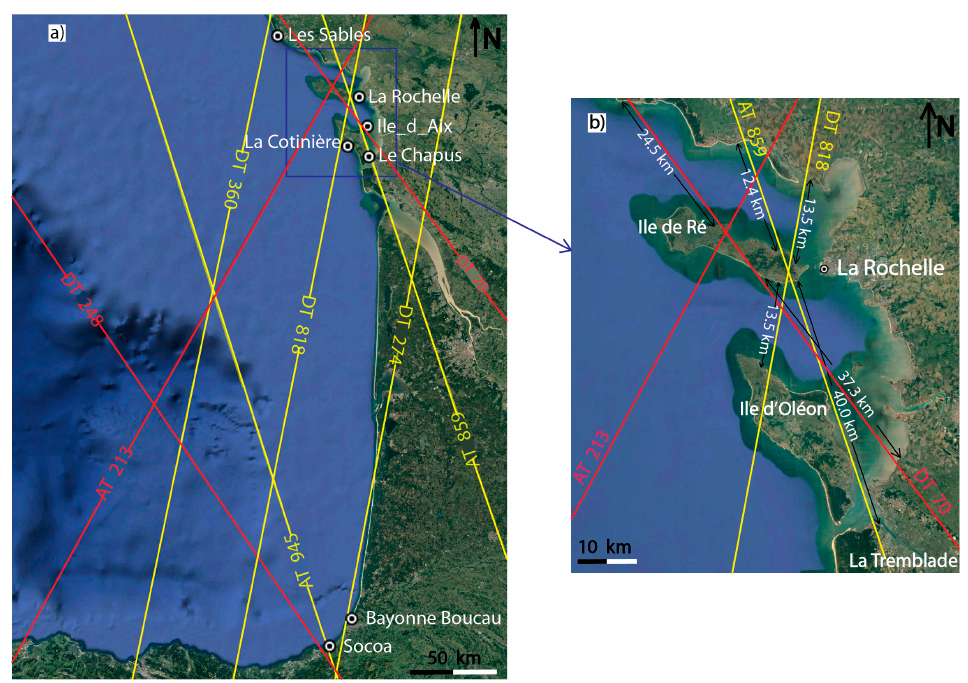
Figure 2. Google Earth image of the study area ( a ) with superposition of theoretical traces altimetry. Jason-1 and Jason-2 tracks are represented with red lines and ERS-2, Envisat, and SARAL tracks with yellow lines; ( b ) detail near La Rochelle tide gauge with Jason-1 and Jason-2 tracks in red lines and ERS-2, Envisat, and SARAL tracks in yellow .